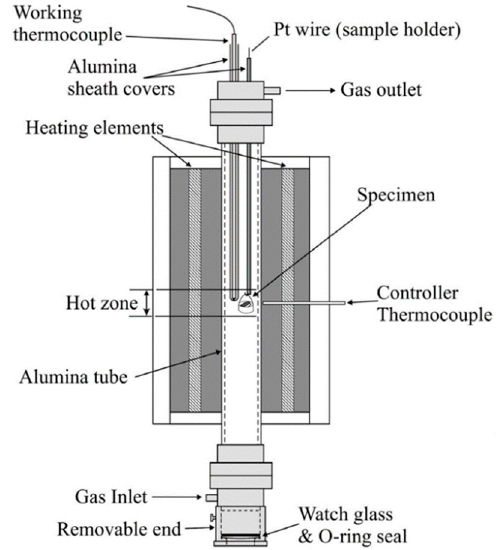
Figure 1. Schematic of tube furnace with specimen for quenching experiments [13].